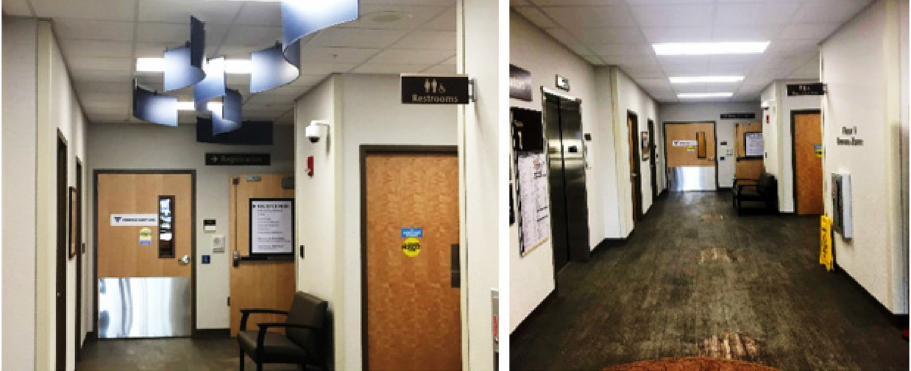
Figure 7 (a, b). Central registration entrance before and